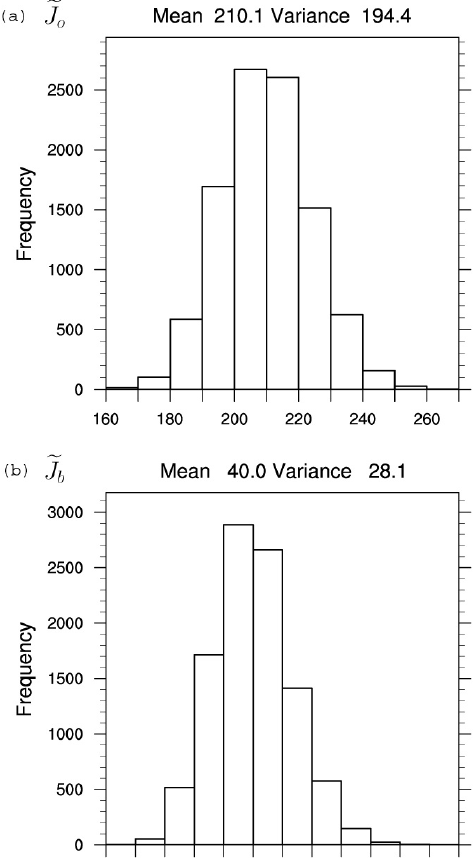
Fig. 2. Histograms obtained with 10 4 realizations of the assimila- tion scheme shown in Fig. 1 for the values of (a) the background cost function and (b) the observation cost function at the